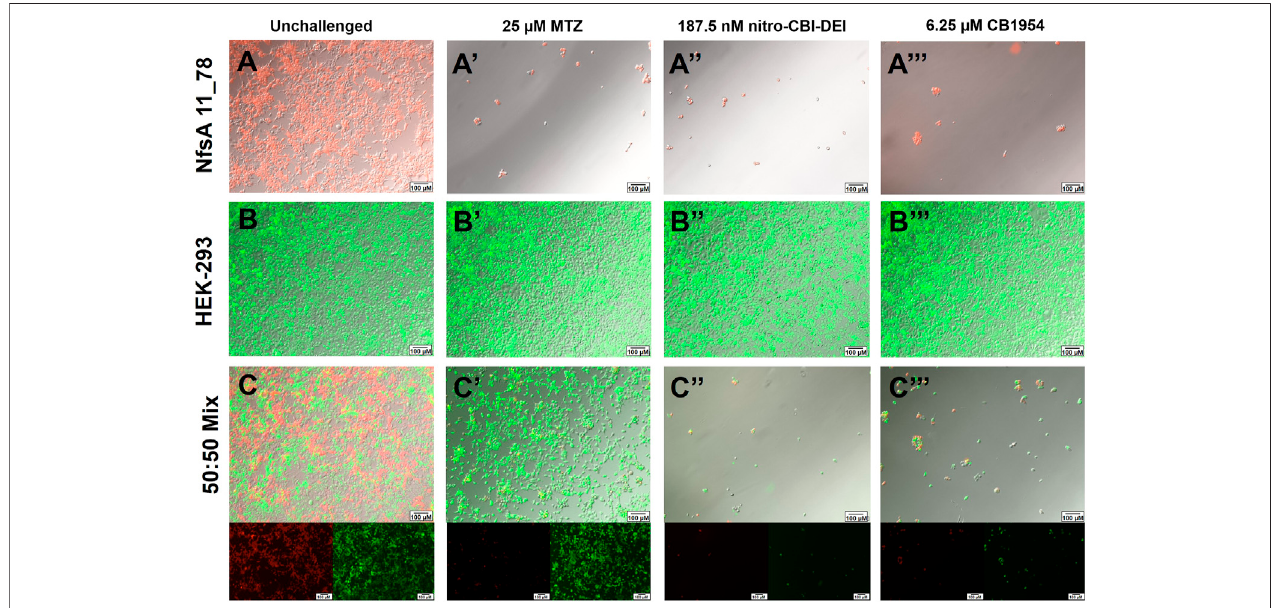
FIGURE 4 | Ablation of mCherry-tagged HEK-293 cells expressing variant 11_78 (red) in co-culture with GFP-tagged nitroreductase-null HEK-293 cells (green) following metronidazole, nitro-CBI-DEI or CB1954 challenge. 11_78-expressing or nitroreductase-null HEK-293 cell lines were fl uorescently tagged with mCherry or GFP respectively and grown in isolation (A,B) or in a 50:50 co-culture of HEK-293:gfp:HEK-293:mCherry+11_78 cells (C) . Cells were challenged with 25 µM metronidazole(MTZ) (A 9 – C 9 ) ,187.5 nMnitro-CBI-DEI (A 0 – C 0 ) ,6.25 µMCB1954 (A - – C - ) oranequivalentvolumeofDMSO (A – C) for48 h,afterwhichcellviability was visualized by fl uorescence microscopy.